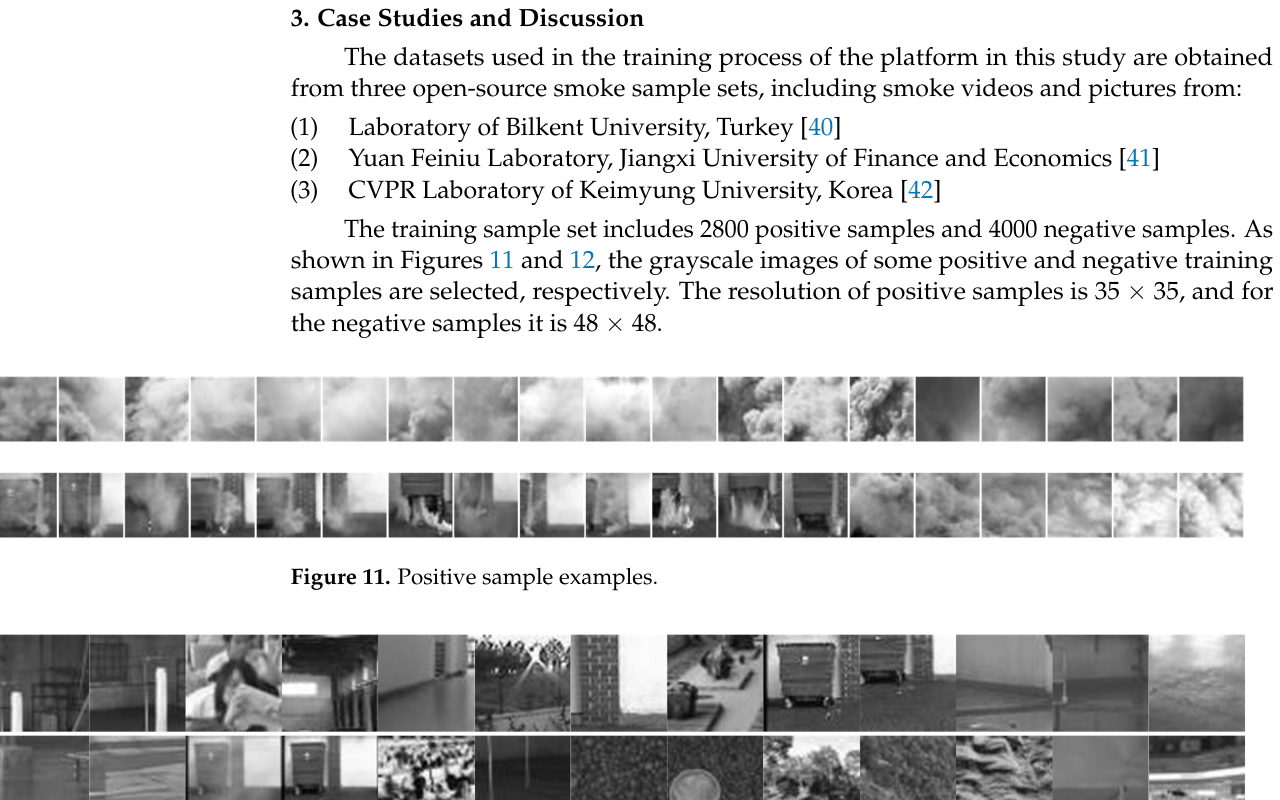
Figure 10. Remote connection interface.